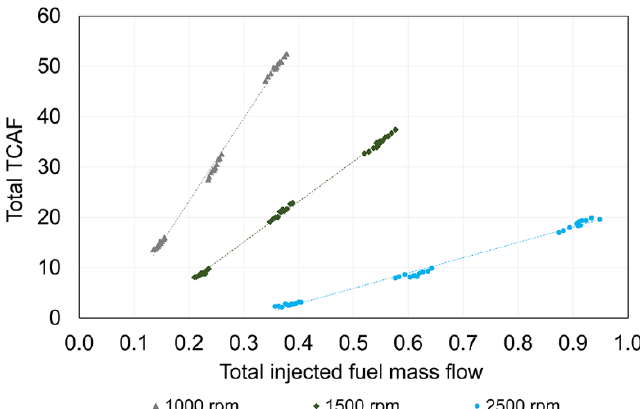
Figure 15. Correlation between total TCAF and total injected fuel mass flow at di ff erent engine speeds and loads (homogeneous and nonhomogeneous injections are considered). Data is normalized with respect to the maximum injected fuel quantity.